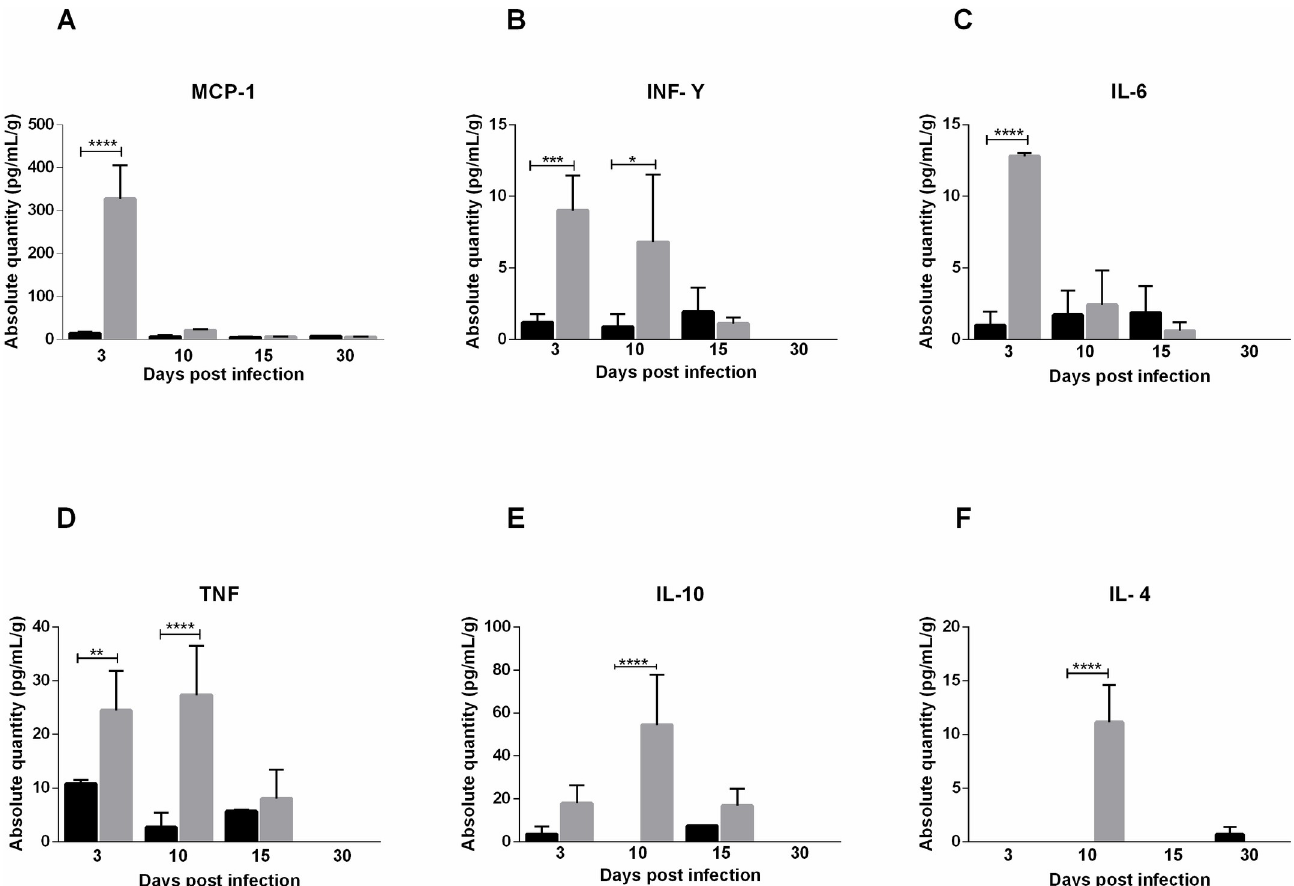
Fig 10. Cytokine profile of 15-day old Balb/c mice infected below the forelimb with 1.25x10 7 PFU. Serum was collected 3, 10, 15 and 30 days post-infection for analysis of cytokine levels. At day 3 PI levels of MCP-1 (A), TNF (B), INF- γ (C) and IL-6 (D) were high, and TNF (B) and INF- γ levels up to the 10th day. IL-10 (E) and IL-4 (F) levels increased at day 10 PI. Statistics were performed with one-way ANOVA, Bonferroni’s multiple comparisons test. Gray bars: Infected. Black bars: negative control. ( � P value � 0.05; �� P value � 0.01; ��� P value � 0.001; ���� P value � 0.0001). N = 3 animals/group.